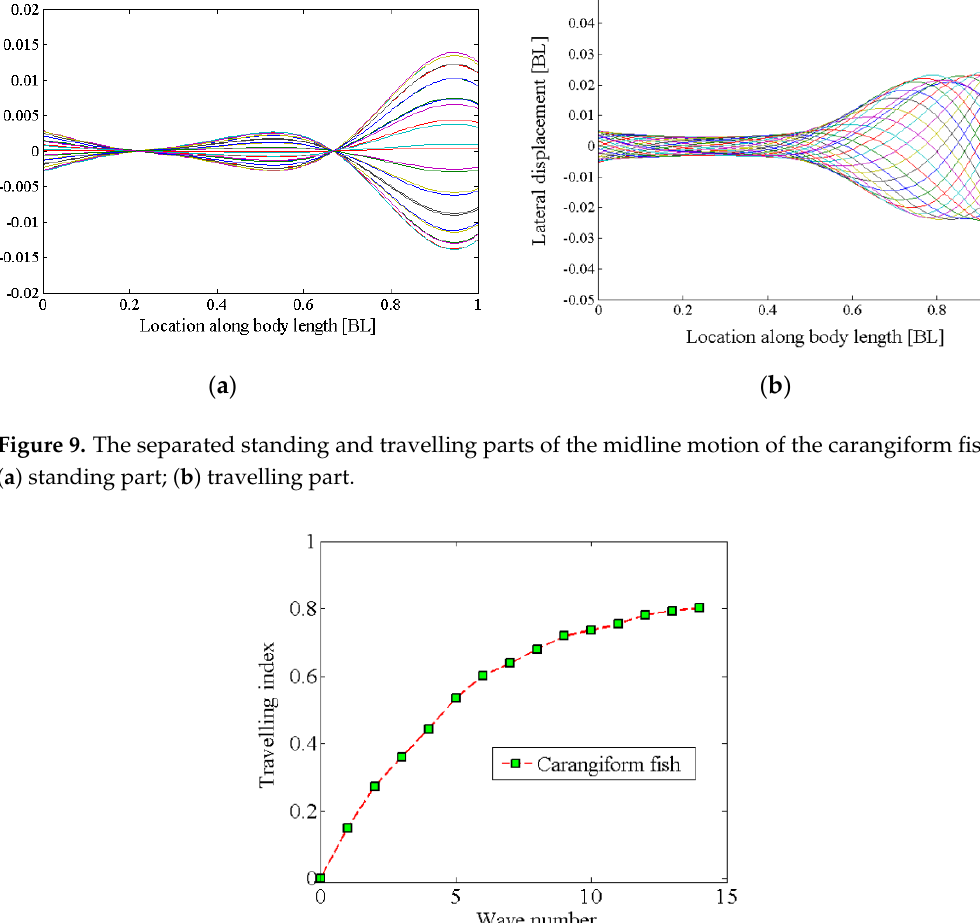
Figure 10. The changing pattern of travelling index along with the wave number.